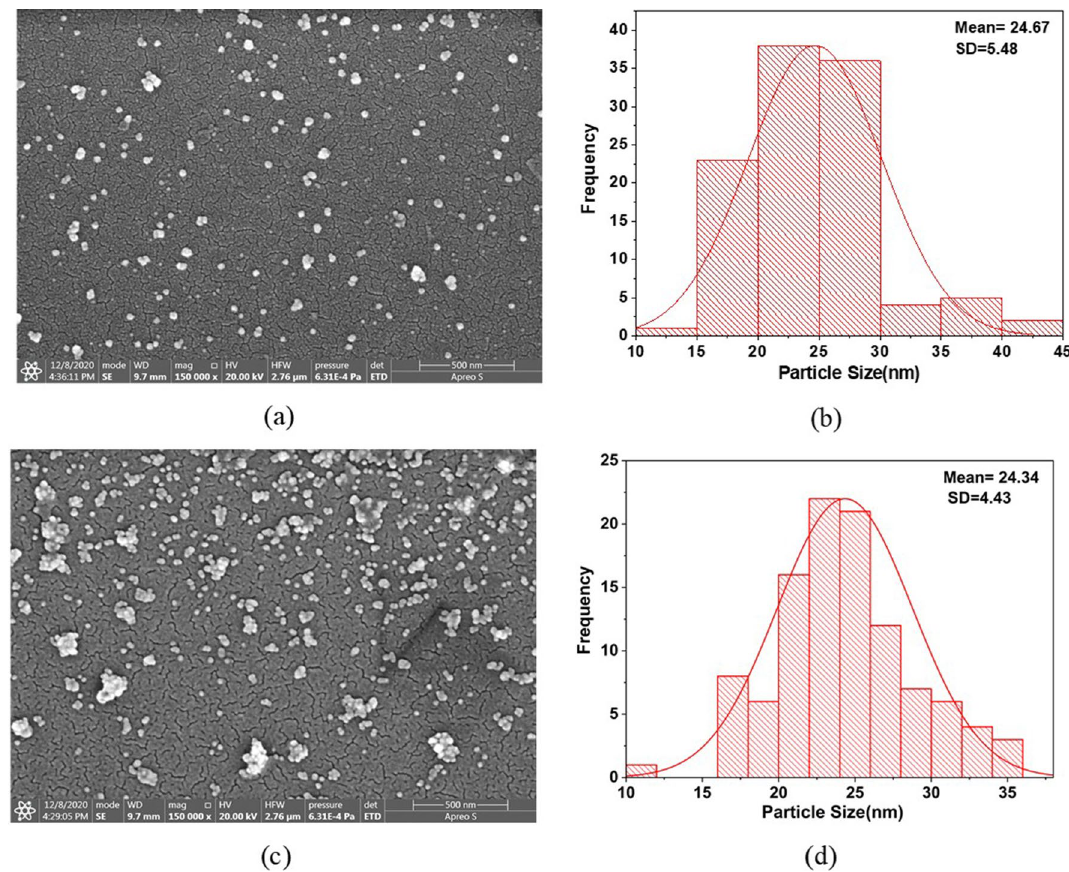
Figure 6. Scanning Electron Microscopy images of GNP with particle distribution obtained through ( a , b ) conventional approach ( c , d ) Microfluidic